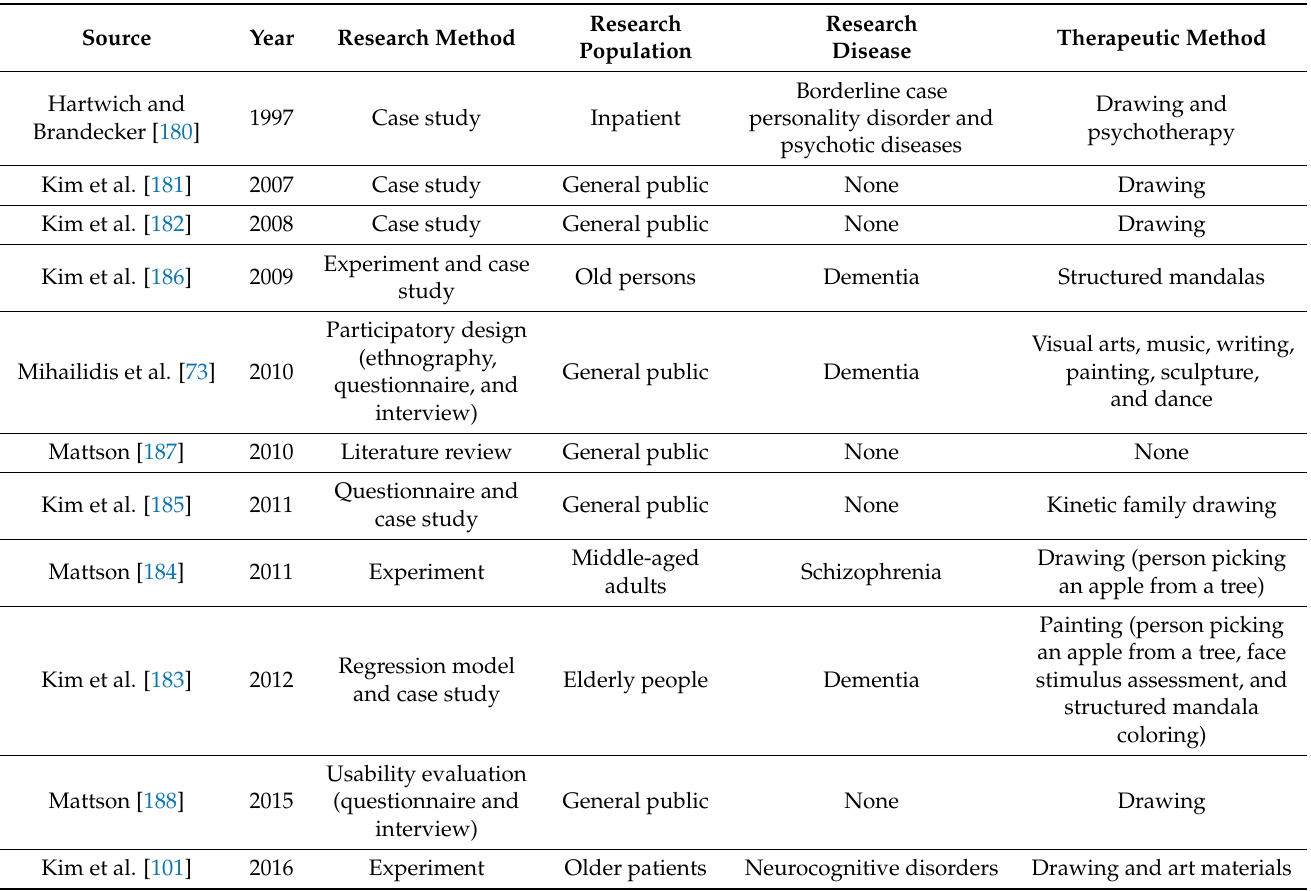
Table 5. The list of studies for computer system in the evaluation of therapeutic effect on AT-aided health and well-being (devised by the